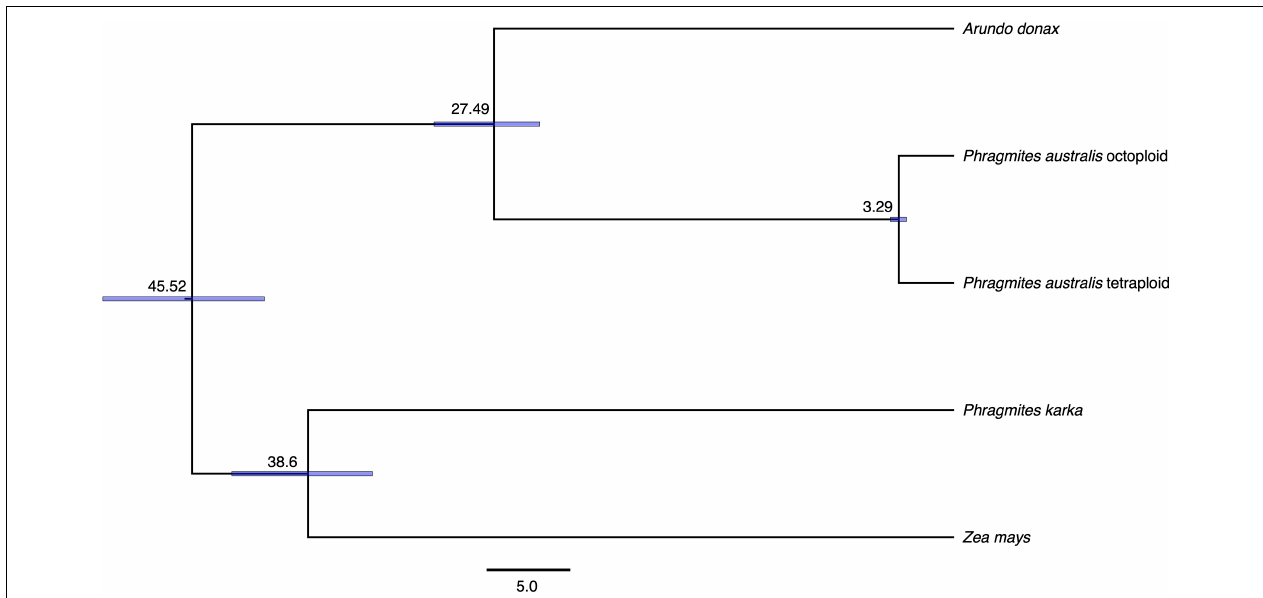
FIGURE 5 | Divergence time estimation of Poaceaespecies based on 98 single copy orthologous genes of five transcriptome assemblies including Zea mays , Arundo donax , Phragmites karka , Phragmites australis octoploid lineage, and Phragmites australis tetraploid lineage. The unit of the estimated divergence time is million years (MY), and the node bar indicated 95% Height Posterior Density of the node